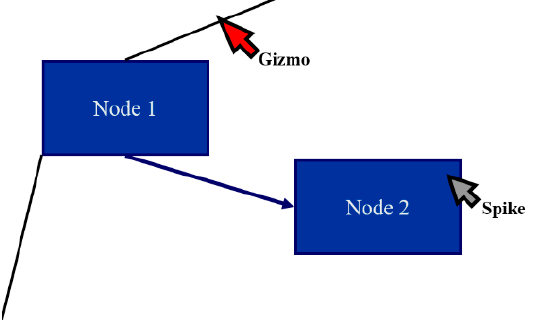
Figure 11. Presence guideline.